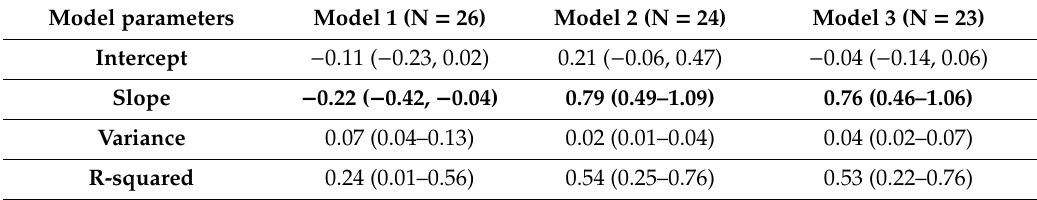
Table 2. Surrogacy parameters of multivariate random e ff ects